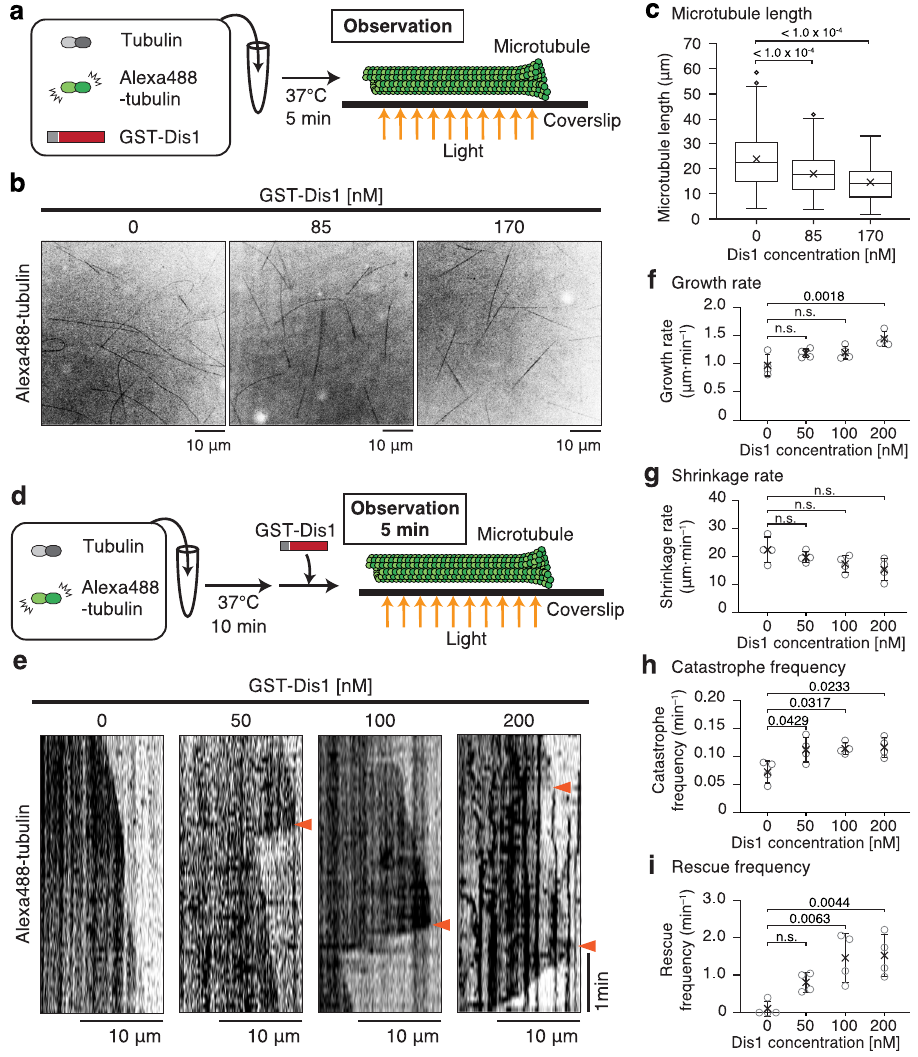
Fig. 1 Dis1 promotes microtubule dynamics in vitro, including induction of catastrophes causing microtubules to shorten. a Experimental outline- puri fi ed tubulin (20 µ M) with Alexa488-labelled tubulins (2 µ M) and 0, 85, and 170 nM of recombinant GST-Dis1 were mixed and incubated at 37 °C for 5 min, followed by observation using a confocal microscope. b Observed microtubules with and without GST-Dis1. c Lengths of microtubules shown in ( b ) were plotted. Box-and-whisker plots indicate the minimum and maximum values and the 25th and 75th percentiles. Bullets indicate outliers; crosses represent means; centre lines represent medians; n = 156 (0 nM), 197 (85 nM), 152 (170 nM) microtubules. d Experimental outline- puri fi ed tubulin (35 µ M) with Alexa488-labelled tubulin (3 µ M) was incubated at 37 °C for 10 min. GST-Dis1 was then added and observed at 5-s intervals for 5 min using the fl uorescent microscope. e Representative kymographs for Alexa488-labelled microtubules with indicated concentrations of GST-Dis1. Arrowheads represent the timing of microtubule catastrophes. f – i Growth ( f ), shrinkage rates ( g ), catastrophe ( h ), and rescue ( i ) frequencies were calculated. Crosses, the mean; bullets, technical replicates: n = 4 (0 nM), 4 (50 nM), 4 (100 nM), 4 (200 nM) experiments. At least 15 microtubules were observed for each experiment. Error bars; SD. The statistical signi fi cance of the difference was determined using one-way ANOVA followed by the Tukey – Kramer method. P values are shown; n.s. not signi fi